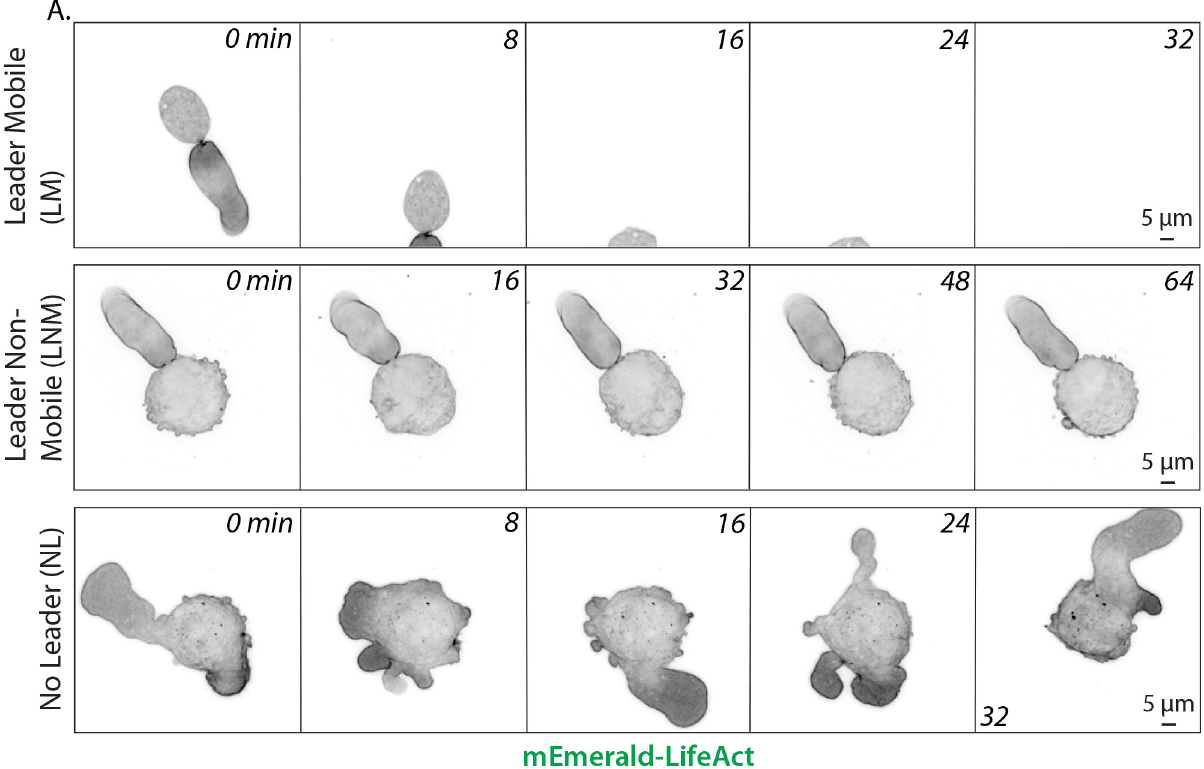
Fig 2. Mechanically confined melanoma cells adopt three distinct phenotypes. A. When confined down to 3 μ m, melanoma A375-M2 cells adopt one of three phenotypes, including leader mobile (LM; form a leader bleb and migrate), leader non-mobile (LNM; form a leader bleb but do not migrate), and no leader (NL; do not form a leader bleb and do not migrate) phenotypes. All cells were transfected with the F-actin marker, LifeAct- mEmerald, before confinement. All data are representative of at least three independent